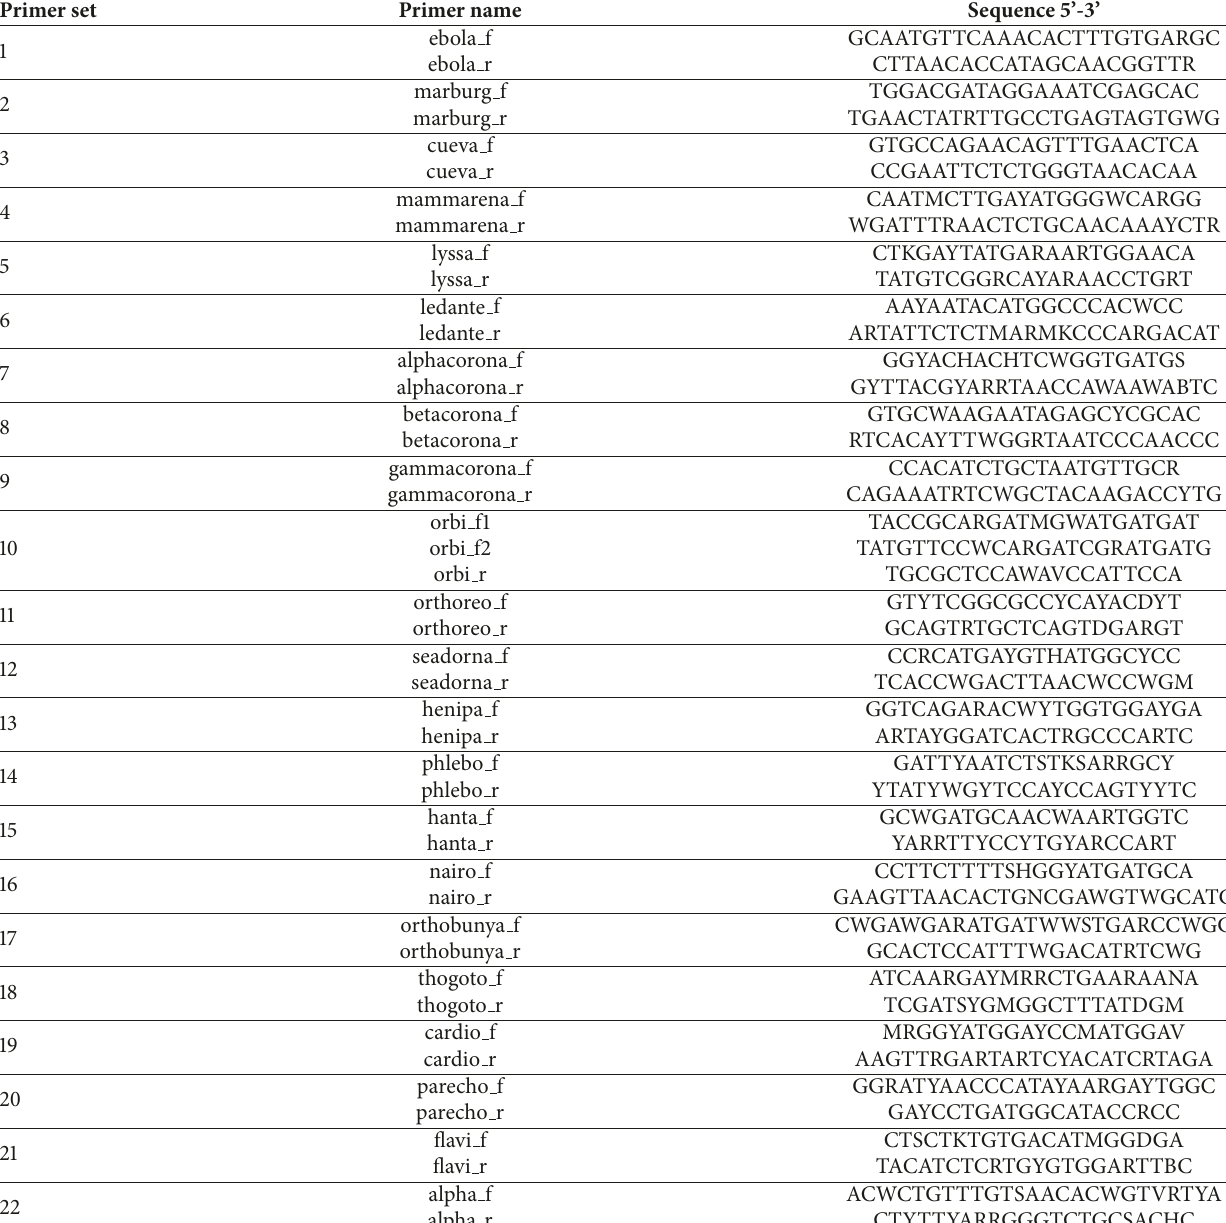
Table 2: Primers used in the panel along with their